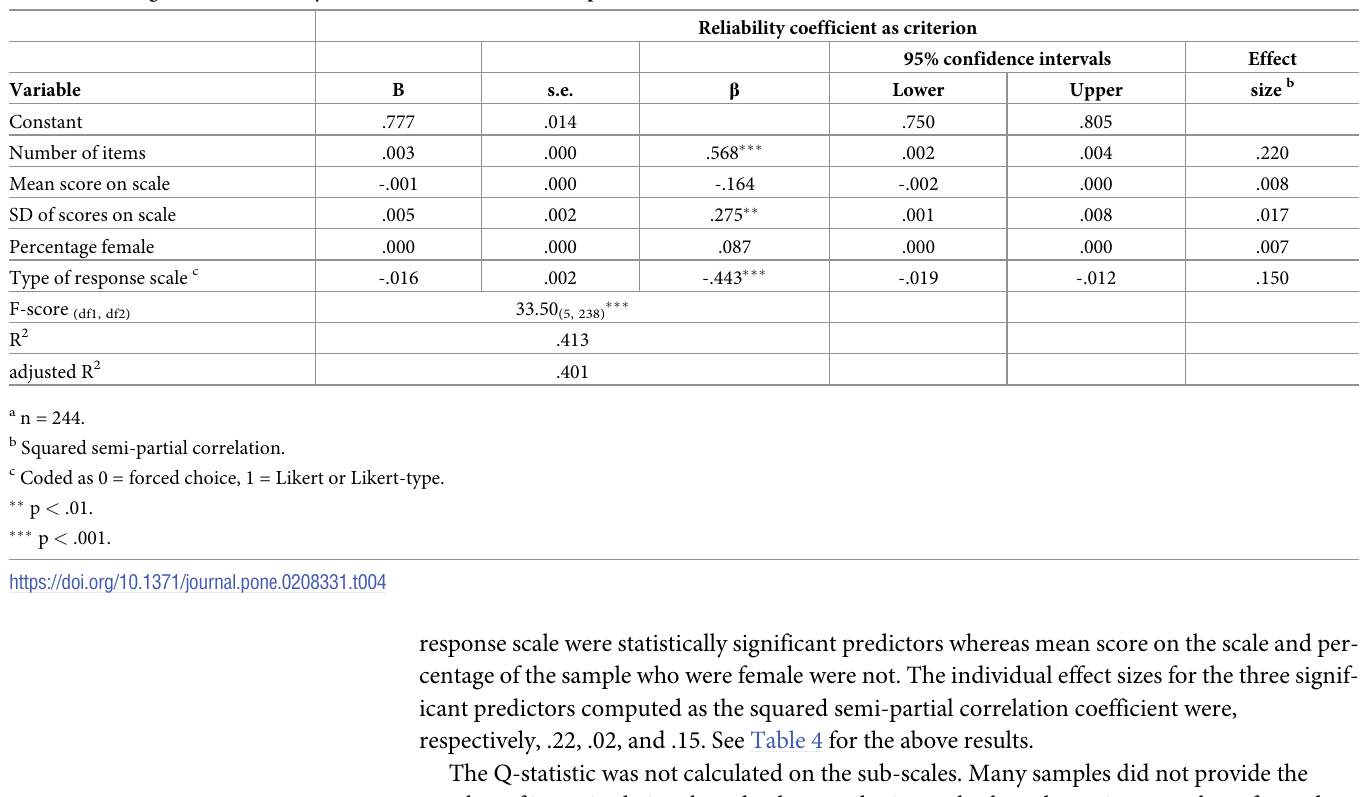
Table 4. Meta-regression of reliability coefficients on three coded sample characteristics a